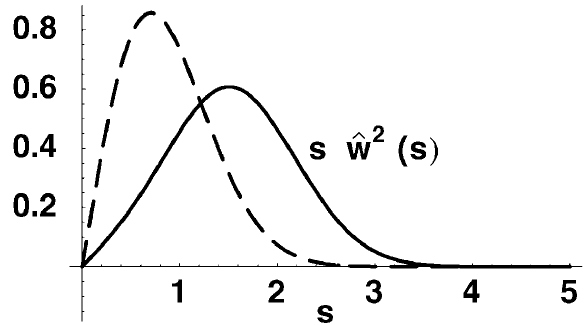
FIG. 13. The variational approximation to the density distri- bution produced by the space charge of a frozen core with (cid:7) (cid:4) 3 (solid line). It is compared with the Gaussian solution (dashed line) corresponding to the case of a purely harmonic potential ( (cid:7) (cid:4) 0 ).